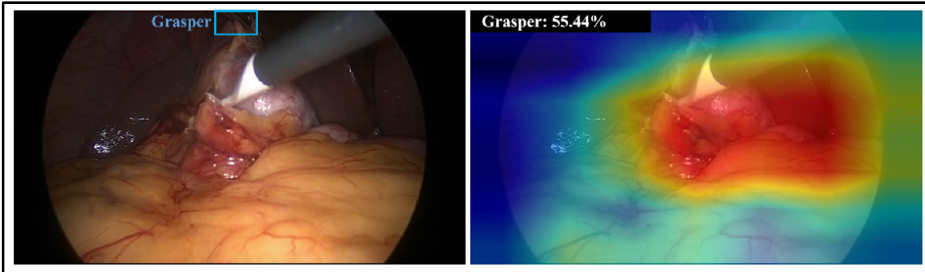
Figure 6. ( left ) a laparoscopic image containing a hook and grasper (in blue box) appearing in the dark area; ( right ) visualisation of class activation maps and prediction probability for grasper class obtained by CNN-80S model.